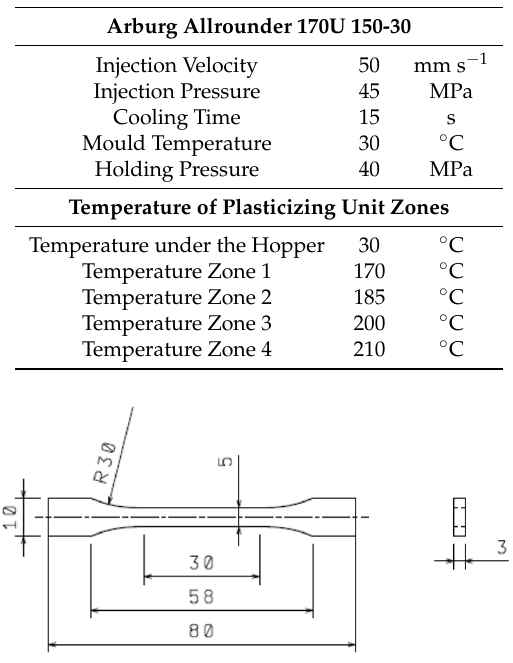
Table 1. Injection moulding parameters.